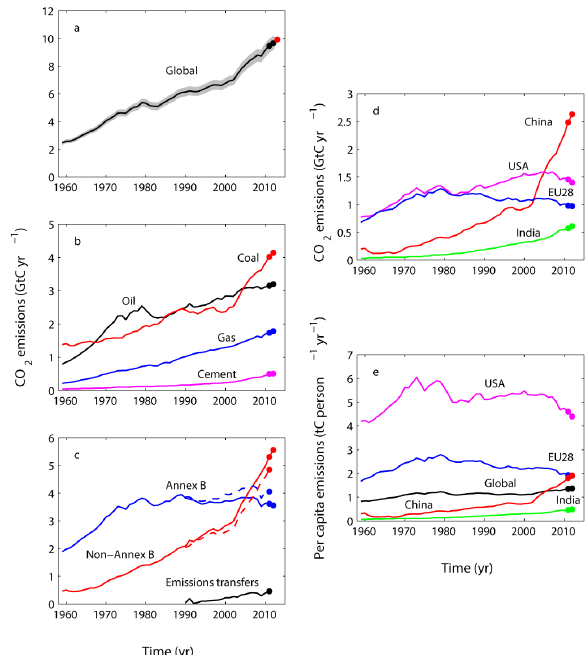
Figure 3. Components of the global carbon budget and their uncer- tainties as a function of time, presented individually for (a) emis- sions from fossil-fuel combustion and cement production ( E FF ) , (b) emissions from land-use change ( E LUC ) , (c) atmospheric CO 2 growth rate ( G ATM ) , (d) the ocean CO 2 sink ( S OCEAN , positive in- dicates a flux from the atmosphere to the ocean), and (e) the land CO 2 sink ( S LAND , positive indicates a flux from the atmosphere to the land). All time series are in GtCyr − 1 with the uncertainty bounds representing ± 1 σ in shaded colour. Data sources are as in Fig. 2. The black dots in (a) , (b) and (e) show values for 2011 and 2012 that originate from a different data set to the remainder of the data, as explained in the text.